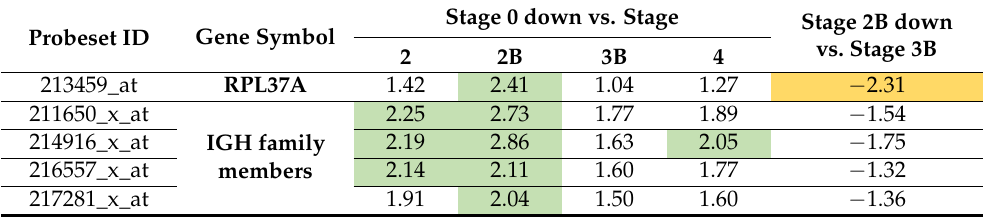
Table 5. Fold change in antigen transcript levels that achieved significance, when comparing AJCC stage. Light green cells indicate values that are increased by greater than 2-fold, yellow cells indicate values that are decreased by greater than 2-fold.